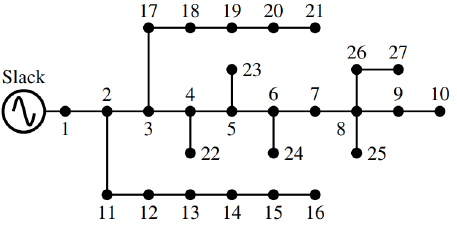
Figure 5. Single-line diagram for the 27-bus test